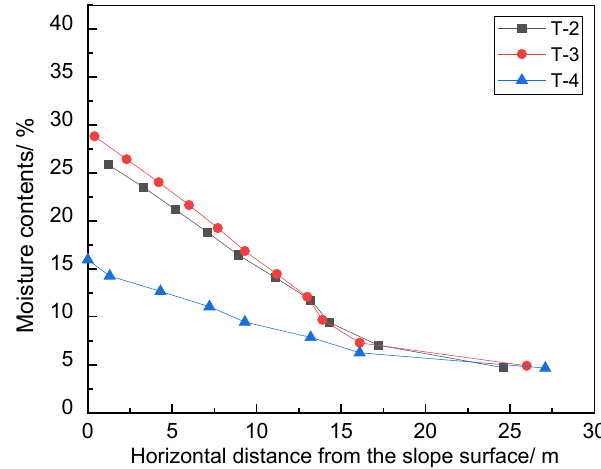
Figure 7. The moisture content of profile at the height of 25.0 .